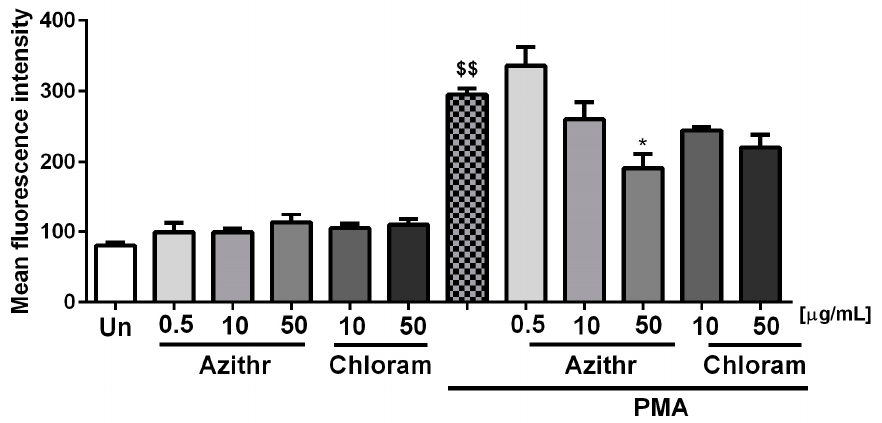
Figure 3. Effect of azithromycin and chloramphenicol on respiratory burst ( n = 6), $$ p ≤ 0.01 vs . unstimulated cells (Un), * p ≤ 0.05 vs . phorbol 12-myristate 13-acetate (PMA).